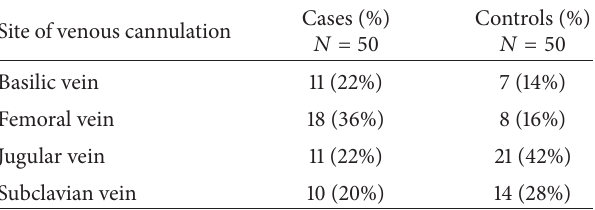
Table 3: Site of venous cannulation.